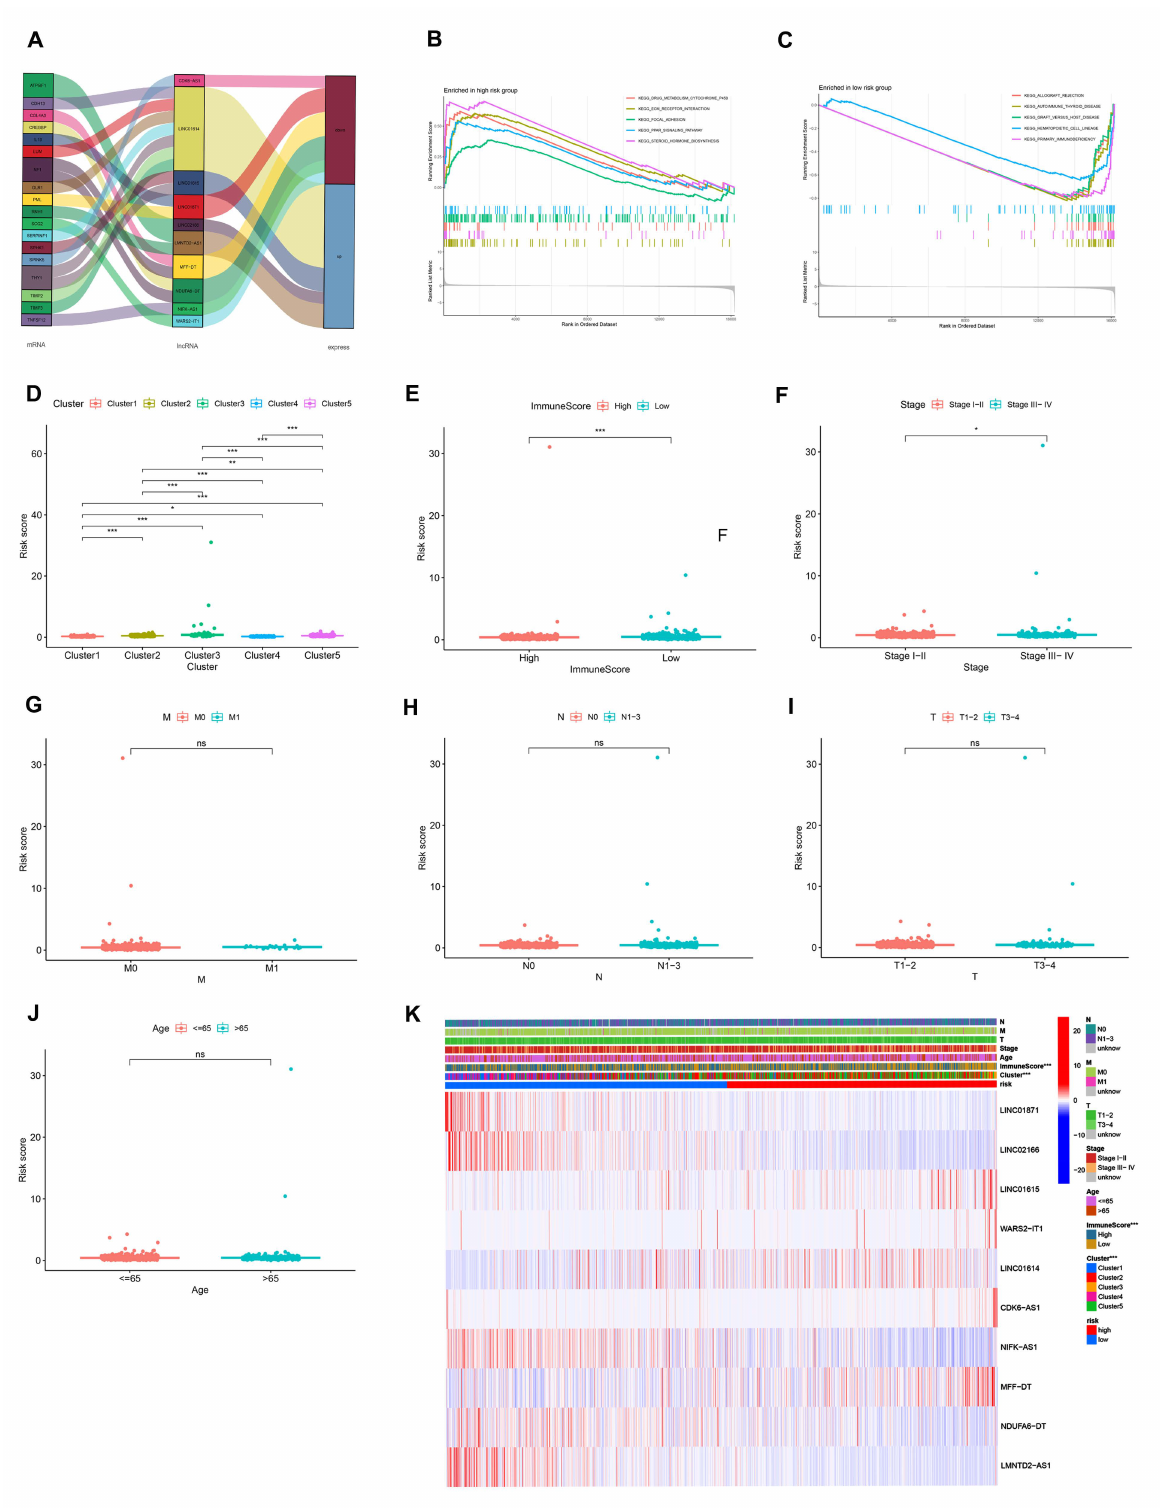
Figure 7. GSEA analysis and clinical evaluation of AR-LncM signatures. ( A ) Sankey diagram observed the correlation of lncRNAs in the model and their expression in cancer tissues and para- cancerous tissues of BC patients. ( B , C ) Different pathways are enriched in low- and high-risk groups. ( D – J ) Differences in risk scores for different clinical features and different BC clusters. ( K ) Heatmaps reveal correlations between clinical features, BC clusters, ImmuneScore, and riskScore. ns, no signifi- cance; * p < 0.05, ** p < 0.01, and ** * p <